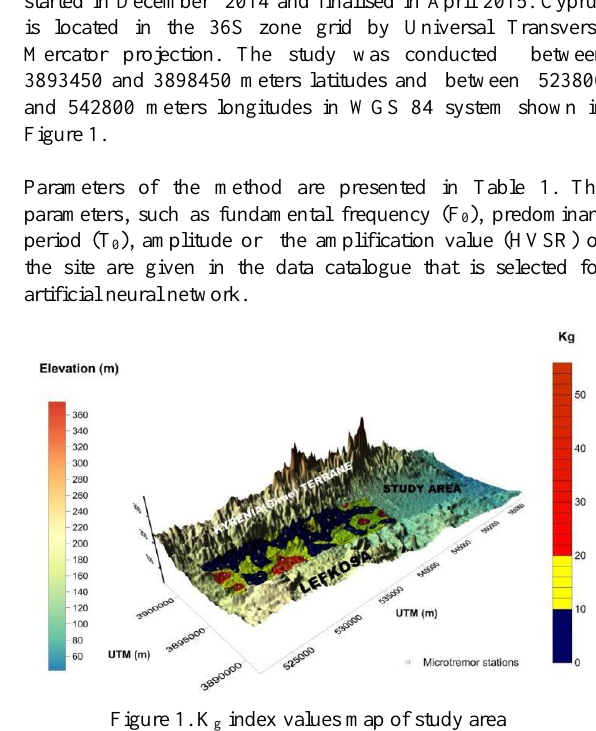
Figure 1. K g index values map of study area